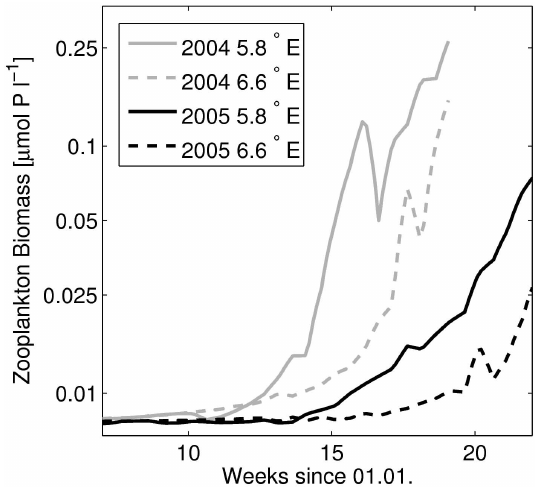
Fig. 7. Simulated zooplankton biomass in µmolP × l − 1 at two loca- tions in 2004 (grey) and 2005